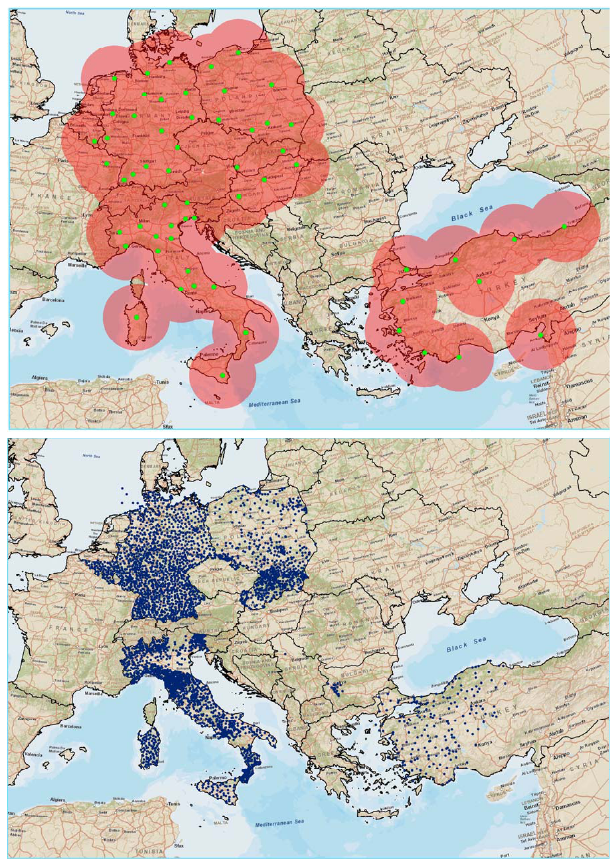
Fig. 1. H-SAF radar (upper) network is composed of the national Fig.1: H-SAF radar (upper) network is composed by the national radar networks of Belgium, 1247 Germany, Hungary, Italy, Poland, Slovakia and Turkey, and H-SAF rain gauge network 1248 radar networks of Belgium, Germany, Hungary, Italy, Poland, Slo- (lower) is composed by the national rain gauge networks of Belgium, Bulgaria, Germany, Italy, 1249 vakia and Turkey, and the H-SAF rain gauge network (lower) is Poland, Slovakia and Turkey (maps by M. Barbani, DPC) . 1250 1251 composed of the national rain gauge networks of Belgium, Bulgaria, Germany, Italy, Poland, Slovakia and Turkey (maps by M. Barbani,